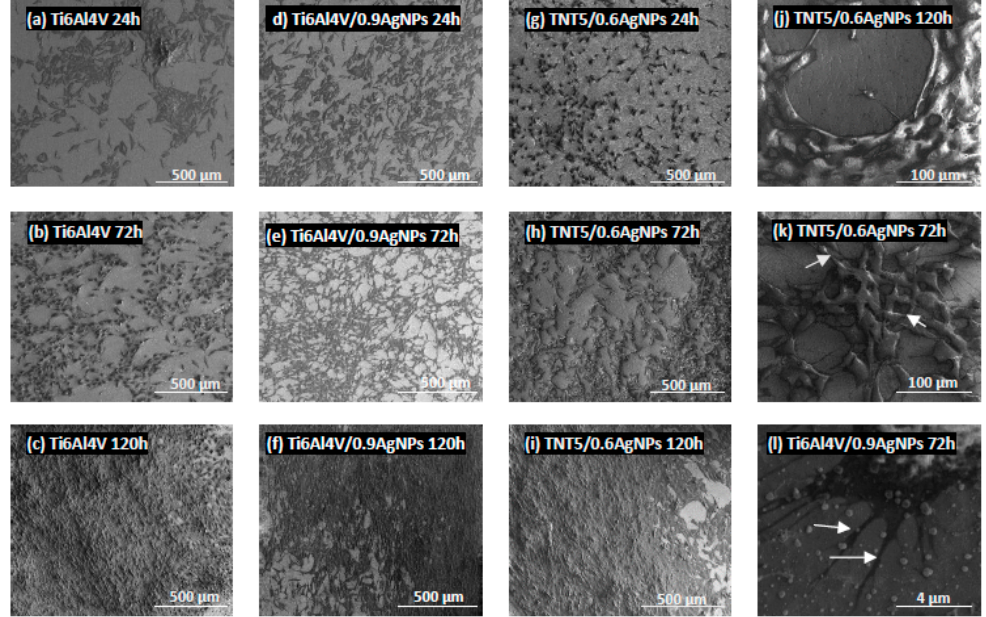
Figure 11. The scanning electron microscopy (SEM) micrographs showing the human osteoblast-like MG-63 cells adhesion (after 24 h) and proliferation (after 72 h and 120 h) growing on the surface of references Ti6Al4V alloy foils ( a – c ), (Ti6Al4V/0.9AgNPs) ( d – f ) or Ti6Al4V/TNT5/0.6AgNPs ( g – i ). The micrograph ( j ) presents the multilayer growth of cells on the surface of Ti6Al4V/TNT5/0.6AgNPs sample. Arrows indicate numerous filopodia, which attached the osteoblasts to the nanocoatings surface ( l ) and filopodia spreading between the cells ( k ).